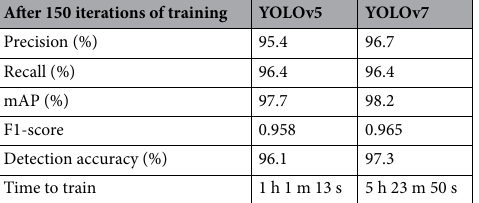
Table 2. Comparison of evaluation indicators between YOLOv5 and